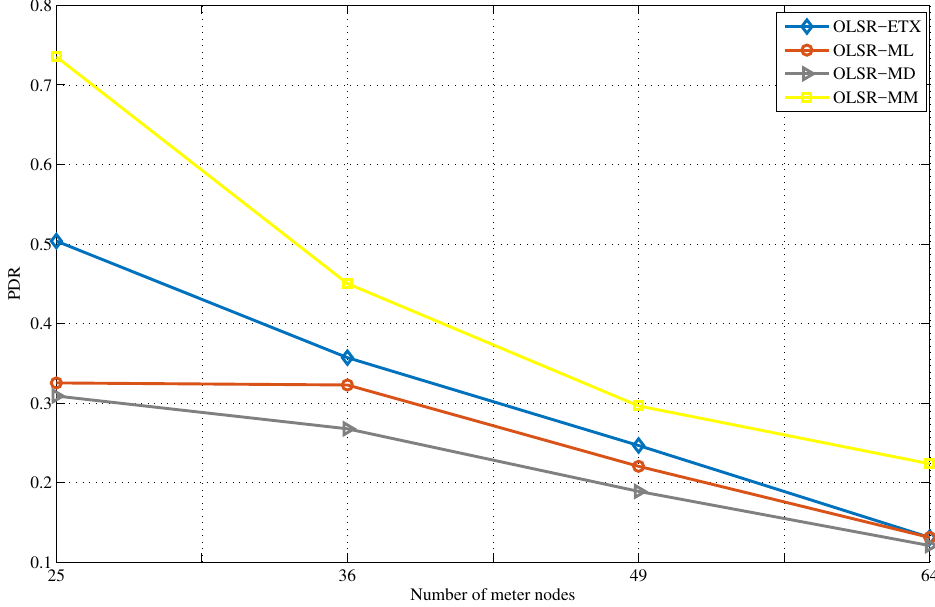
Figure 13. PDR for SG application on grid clusters with the data concentrator placed at the top